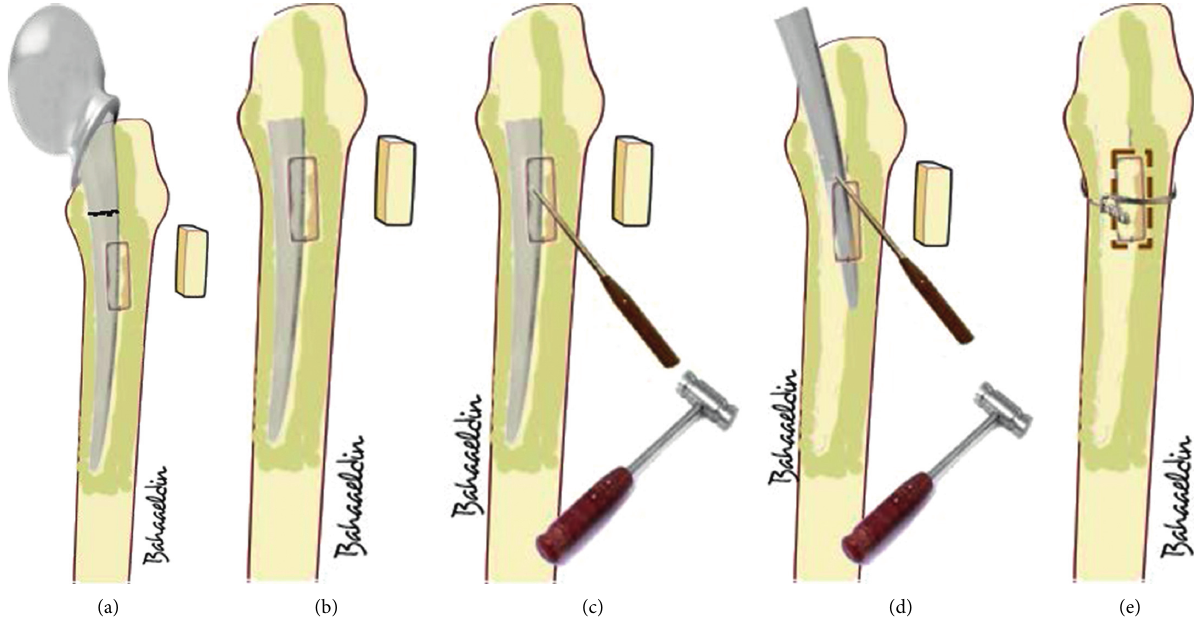
Figure 1: Sequence of events to extract fractured femoral stem. (a) Broken stem of Thompson prosthesis (b) rectangular bone window (1.5cm width and 2.5cm length) at the lateral aspect of the femoral shaft just distal to the lesser trochanter. (c) Small osteotome settled on the surface of the stem in an angle about 45 ° with the stem. (d) Hammering process to extract the distal part of the stem. (e) Cortical bone window is closed and secured with cerclage (diagrams were designed by Dr. Bahaaeldin